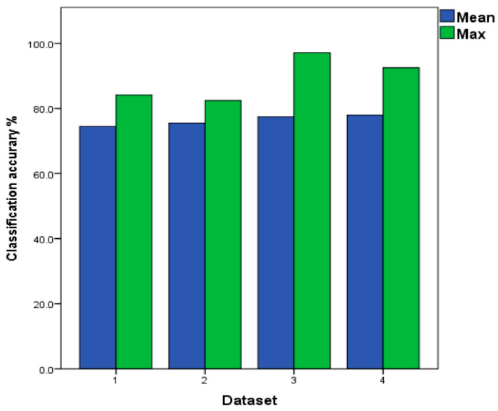
Figure 11. The Mean and Maximum values of Improved LSTM under the Four Datasets.